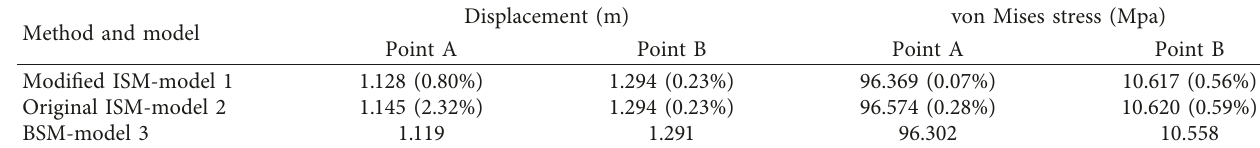
Table 1: Peak displacement and von Mises stress of different points.